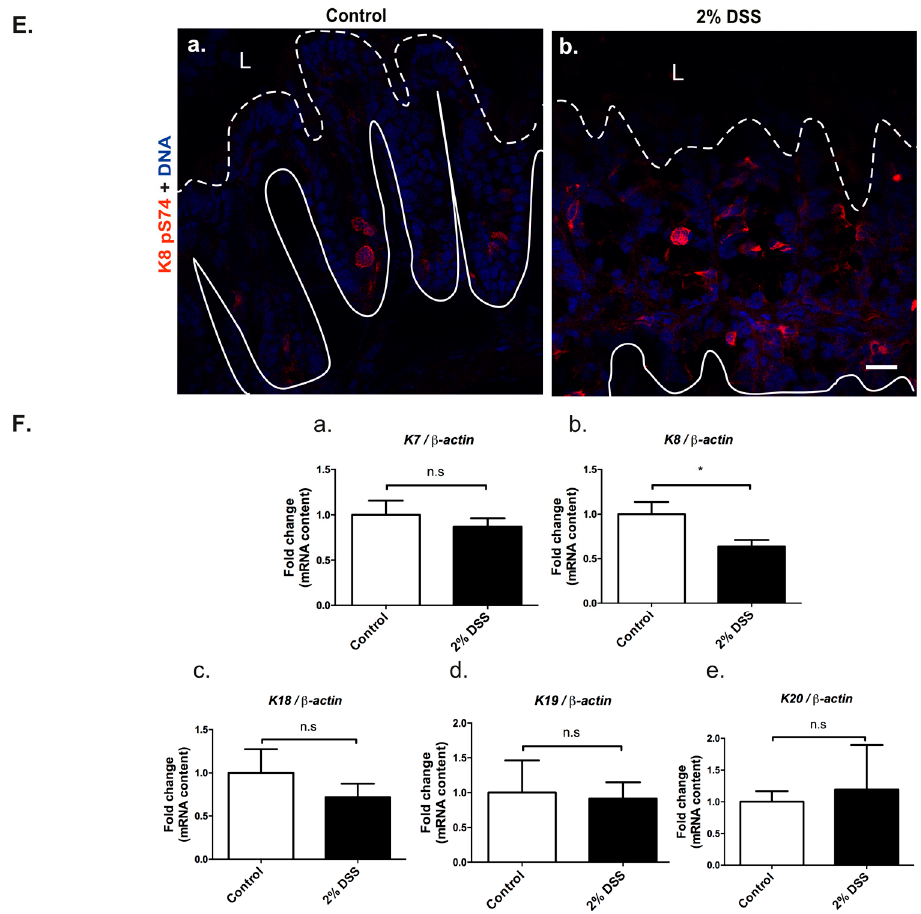
Figure 1. Experimental 2% dextran sulphate sodium (DSS)-induced colitis alters keratin levels and increases K8 phosphorylation at S74. To induce active murine colitis, mice ( n = 3 for controls, lanes 1–3 in B and n = 6 for DSS-treated, lanes 4–9 in B; strain Balb/c) were treated with 2% DSS in drinking water. Samples were collected for protein, RNA and immunofluorescence analysis 8 days after the start of the treatment. ( A ) The daily DAI was calculated on the basis of measurements of body weight loss, stool consistency and presence of blood in stool in order to quantify colitis progression. The arrow indicates time point of sacrifice and sample collection. ( B , C ) Downregulation of K8 and K18 and upregulation of K7, K19 and K20 was detected and quantified using Western blot analysis of colon protein samples normalized by protein assay and the loading control Hsc70. * p < 0.05, ** p < 0.01. ( D ) Despite the K8 downregulation, an increase in K8 pS74 as normalized to K8 levels was seen. *** p < 0.001. ( E ) Immunofluorescence staining of K8 pS74 (red) showed more K8 pS74 positive cells in DSS-treated colons (panel b) compared to controls (panel a). Lines indicate the location and orientation of colonic crypts; dashed lines indicate the border between lumen and epithelium and solid lines the border between epithelium and basement membrane. Nuclei (DNA) are shown in blue. L = Lumen, scale bar = 50 µ m. ( F a– F e) Gene transcription analysis of K7, K18, K19 and K20 showed no significant changes, while K8 gene expression was decreased compared to control mice (normalization to β -actin). n.s = not significant, * p < 0.05. Numerical data are shown as average ± SD. Statistical significance for Western blot and mRNA data was determined by t-test.